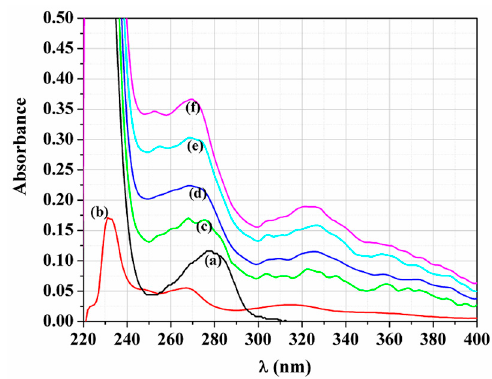
Figure 7. UV spectra of ( a ) 1.5 μ MBSA; ( b ) 20 μ M compound 3; ( c ) compound 3 (3.0 μ M) + BSA (1.5 μ M); ( d ) compound 3 (6.0 μ M) + BSA (1.5 μ M); ( e ) compound 3 (9.0 μ M) + BSA (1.5 μ M); ( f ) compound 3